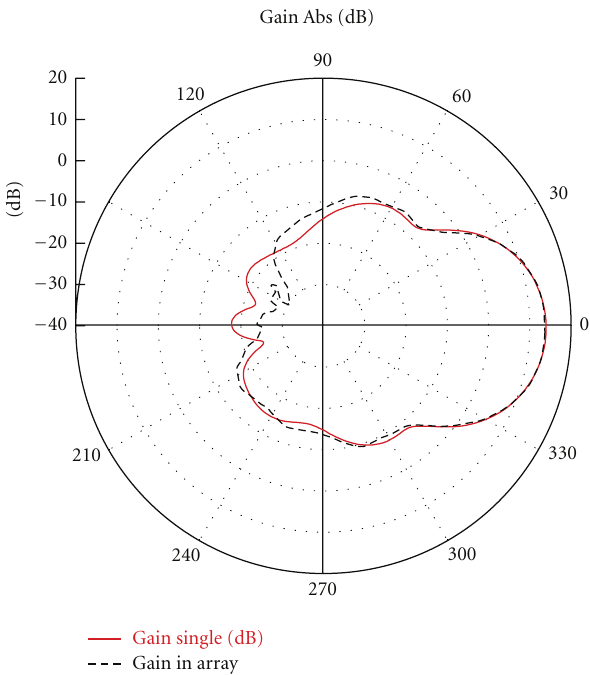
Figure 4: Comparison between isolated (solid-red) and the 5th array element (dashed-brown) radiation patterns.